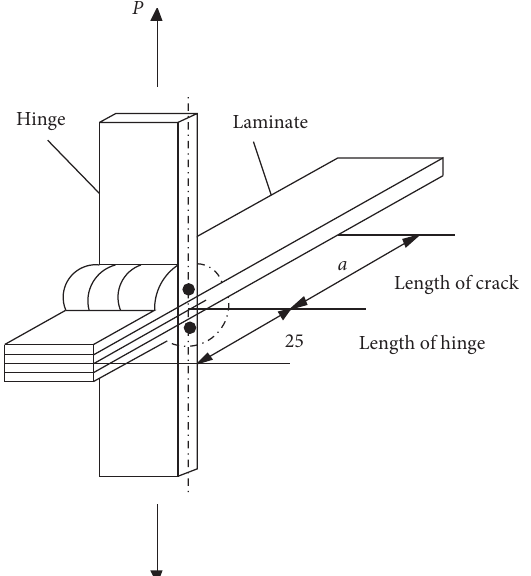
Figure 10: DCB method for measuring interlaminar fracture toughness